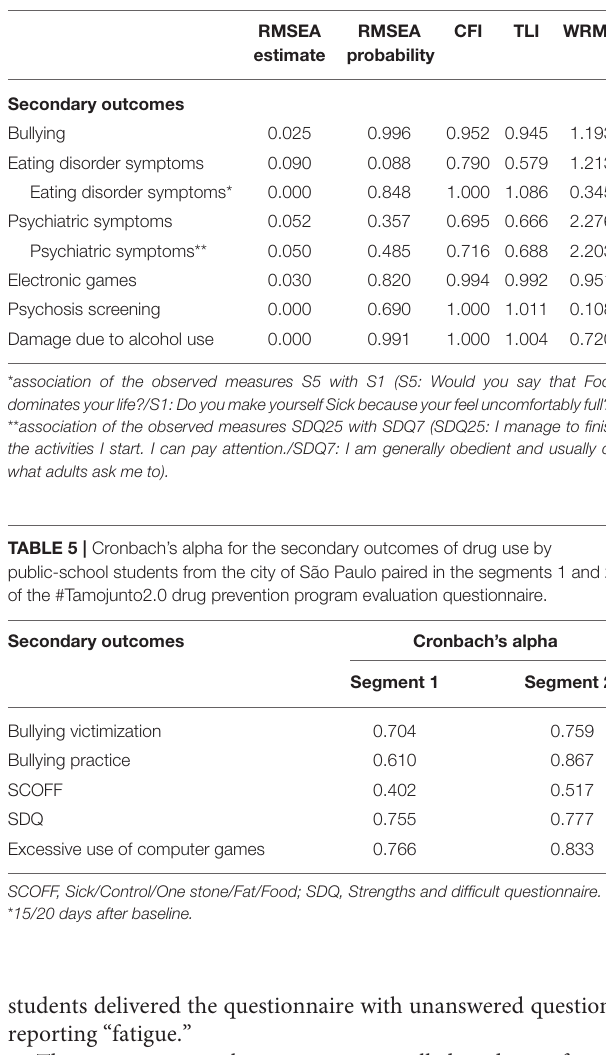
TABLE 4 | The construct validity and fit of the dimensional models of secondary outcomes by public-school students from the city of São Paulo paired in the segments 1 and 2 of the #Tamojunto2.0 drug prevention program evaluation questionnaire.